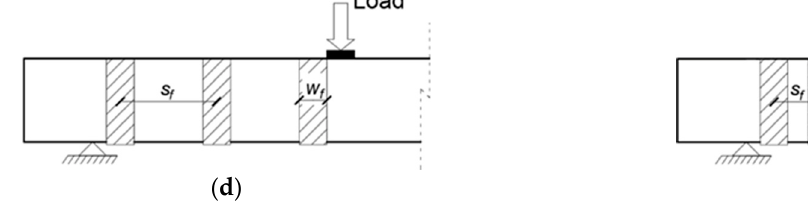
Figure 1. Loading scheme and internal reinforcement; strengthening configuration of ( a ) four strips, ( b ) continuous, ( c ) two strips, ( d ) three strips and ( e ) five strips. Beams were designated as follows: B-Control identifies the control beam while the strengthened beams were identified with the notation B-nL-mS , where B indicates the beam specimen, nL is the number of fabric layers, and mS is the number of U-shaped SRG strips externally bonded to the beams in the shear span. The tested beams are subdivided into two Series: Series II groups the beams designed as B-1L-2S, B-2L-2S, B-1L-5S, and B- 2L-5S while Series I groups the remaining ones [1]. Table 1. Details of tested beams.